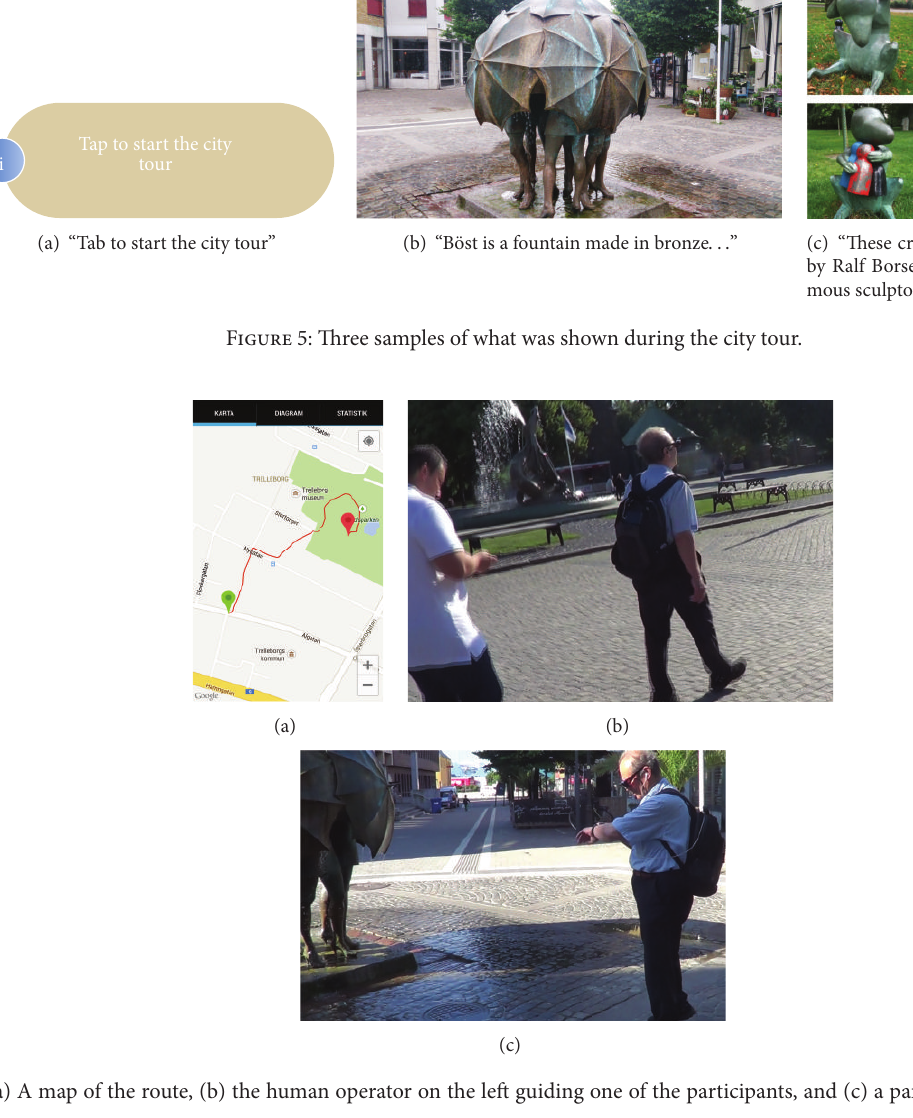
Figure 6: (a) A map of the route, (b) the human operator on the left guiding one of the participants, and (c) a participant interacting with the